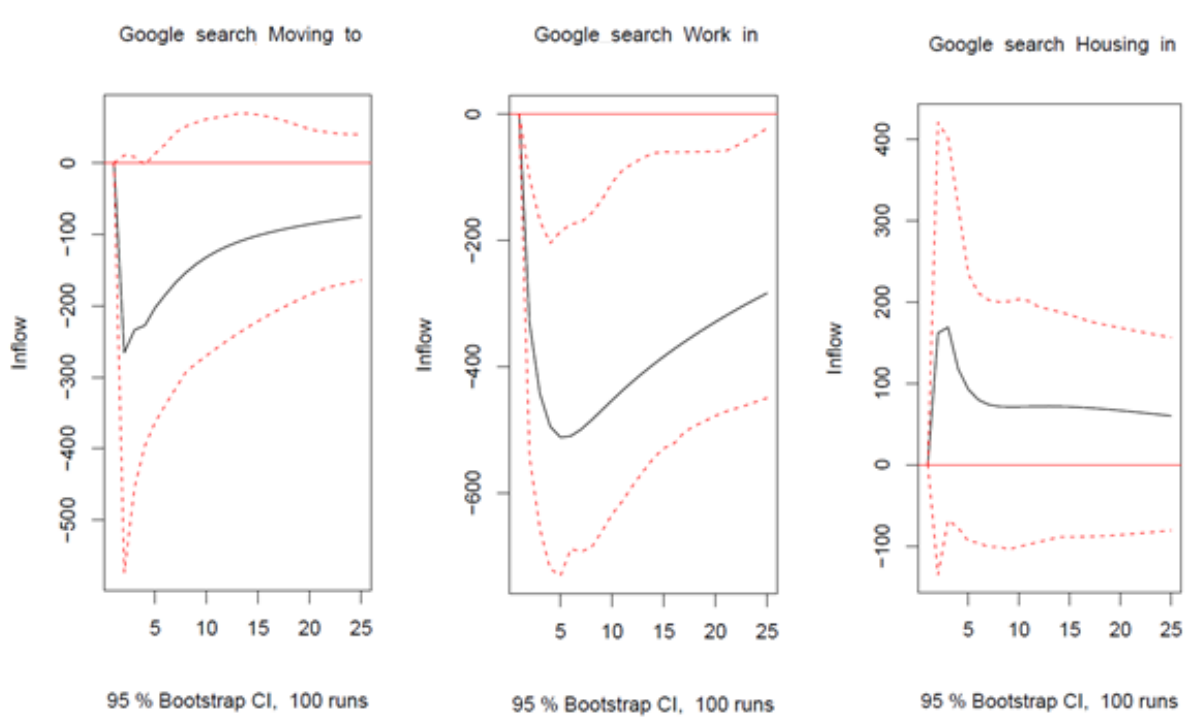
Figure 4. VAR (1) with centered seasonal dummies: orthogonalized impulse responses from a shock in Google searches on migration inflow in Saint Petersburg over 24 months.